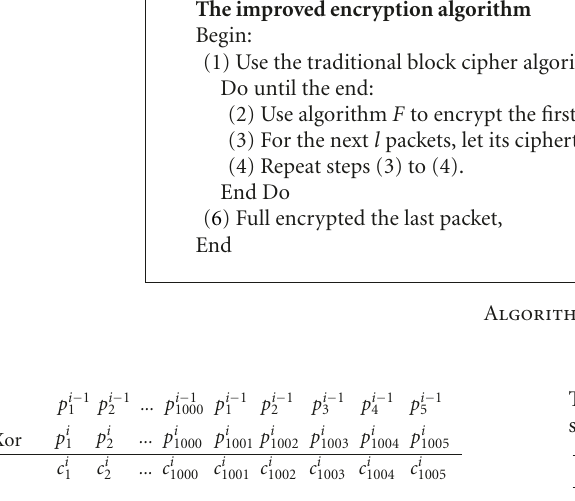
Figure 8: Rear padding in packet-based SAME.